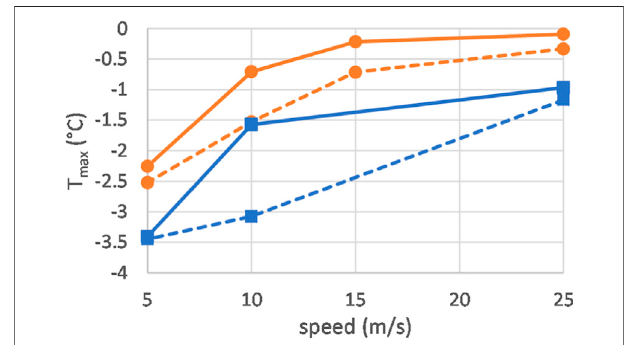
FIGURE 4 | T max of the fl at ski (blue squares) and the XC ski (orange circles) vs. speed in the fi rst run (dashed lines) and last run (solid lines) of fi ve runs.